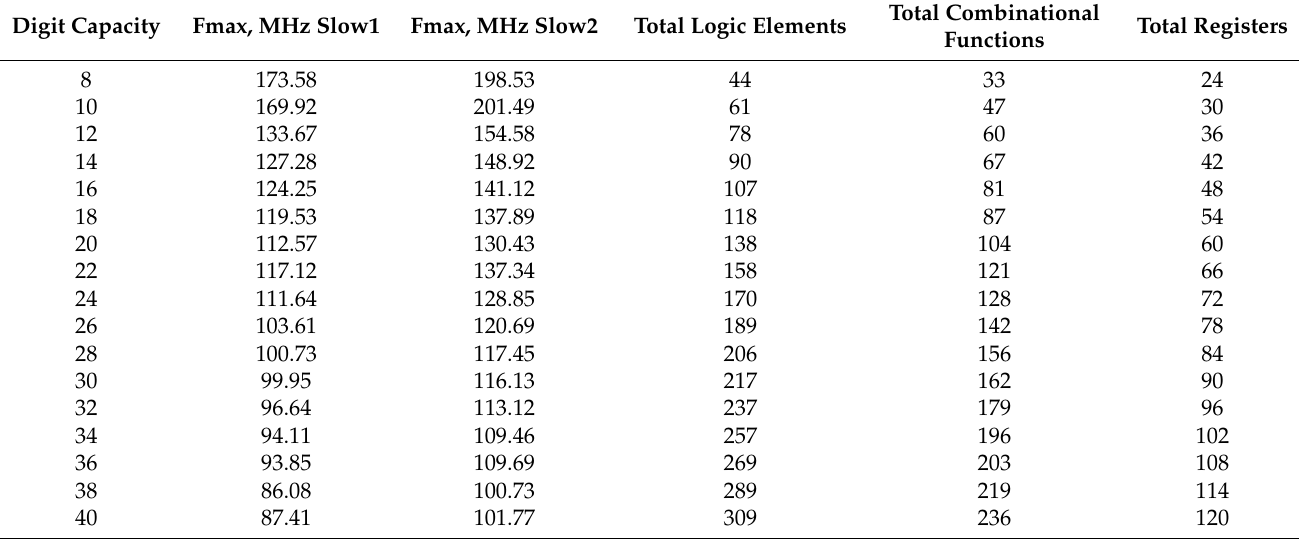
Table 8. Characteristics of the CCM, implementing the proposed algorithm of multiplication.